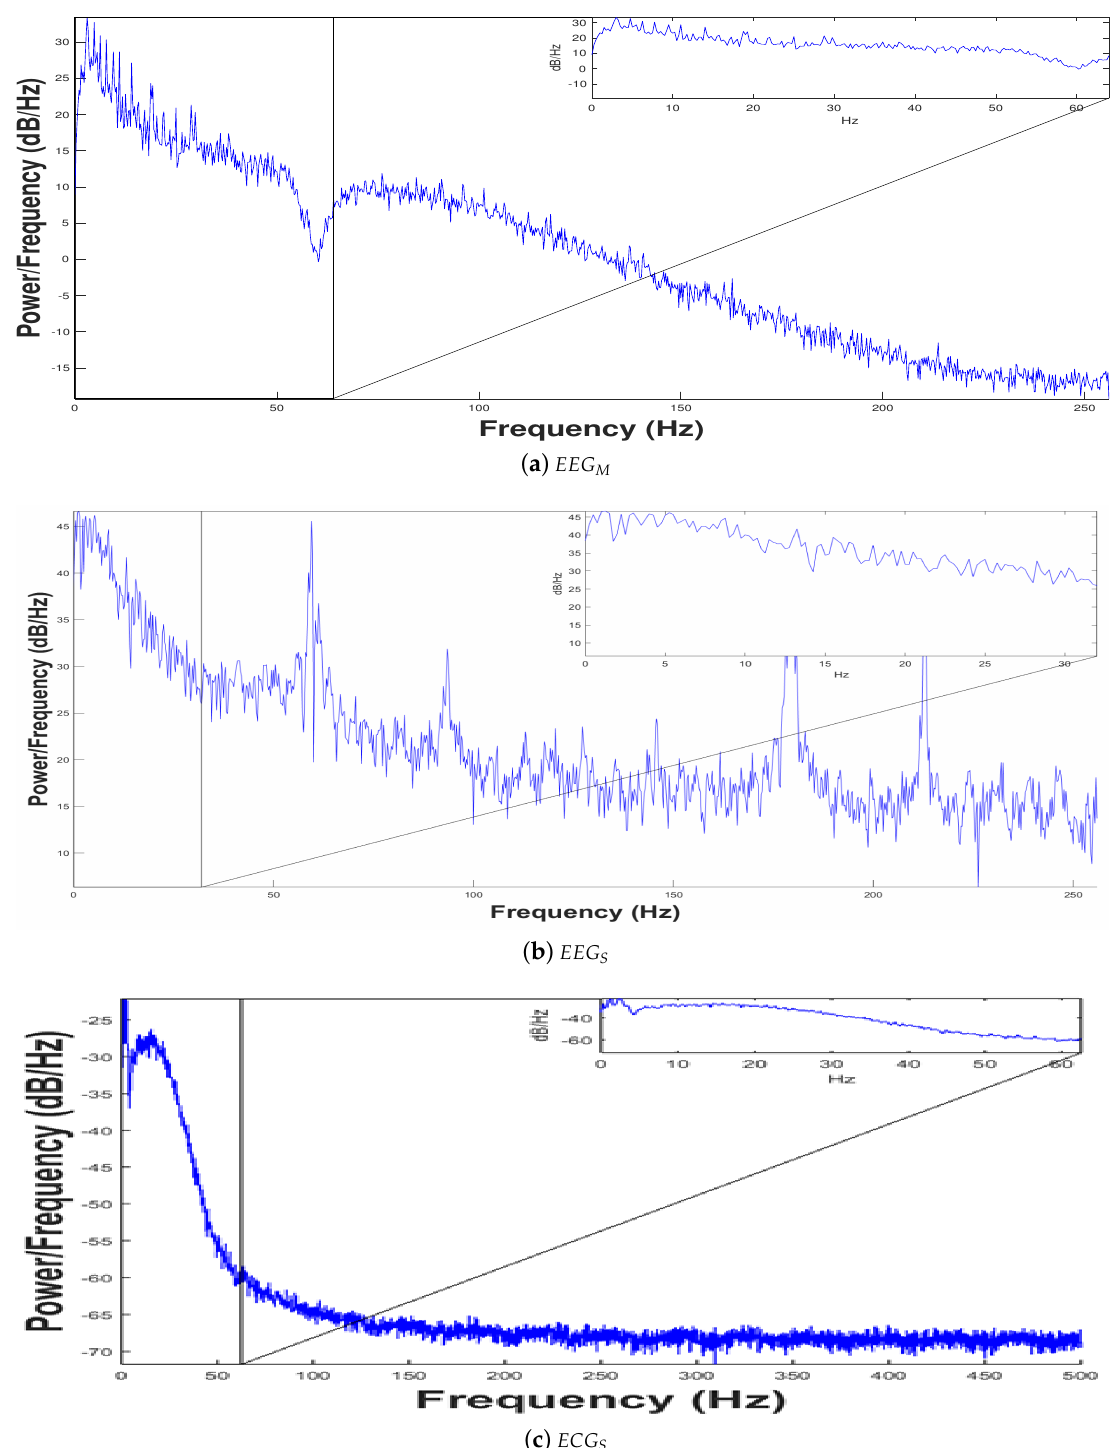
Figure 27. Analysis of biomedical signal interfaces: Power analysis or